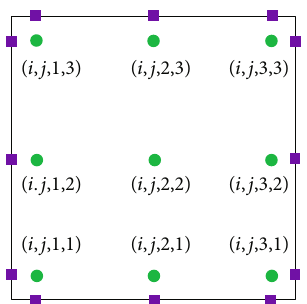
Figure 2: Distribution of solution points and fl ux points of 2D CPR in ð i , j Þ -th cell. Solution points are marked in green dot and fl ux points on element boundary in purple square. The fl ux points inside the CPR cell coincide with the solution points.